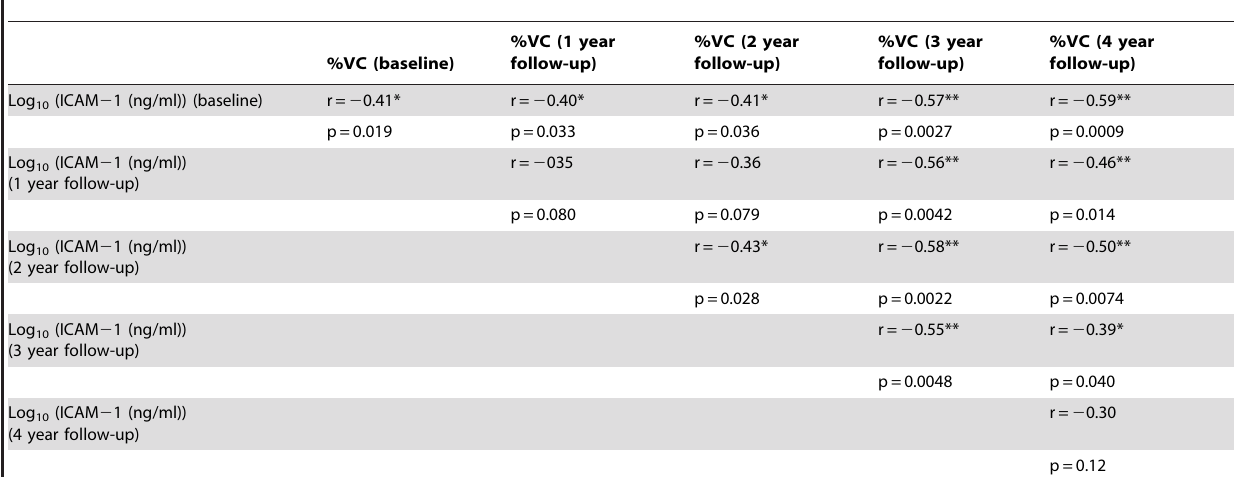
Table 3. The associations between ICAM 2 1 levels and subsequent %VC in patients with